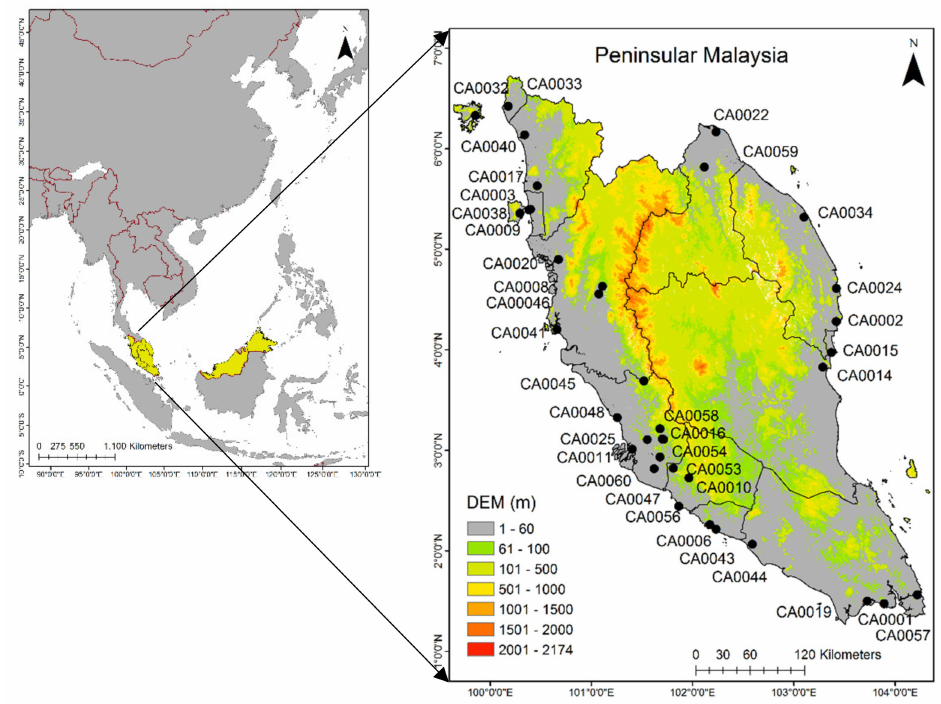
Figure 1. Location of Peninsular Malaysia and distributions of T a meteorological stations overlaid with digital elevation model (DEM) in